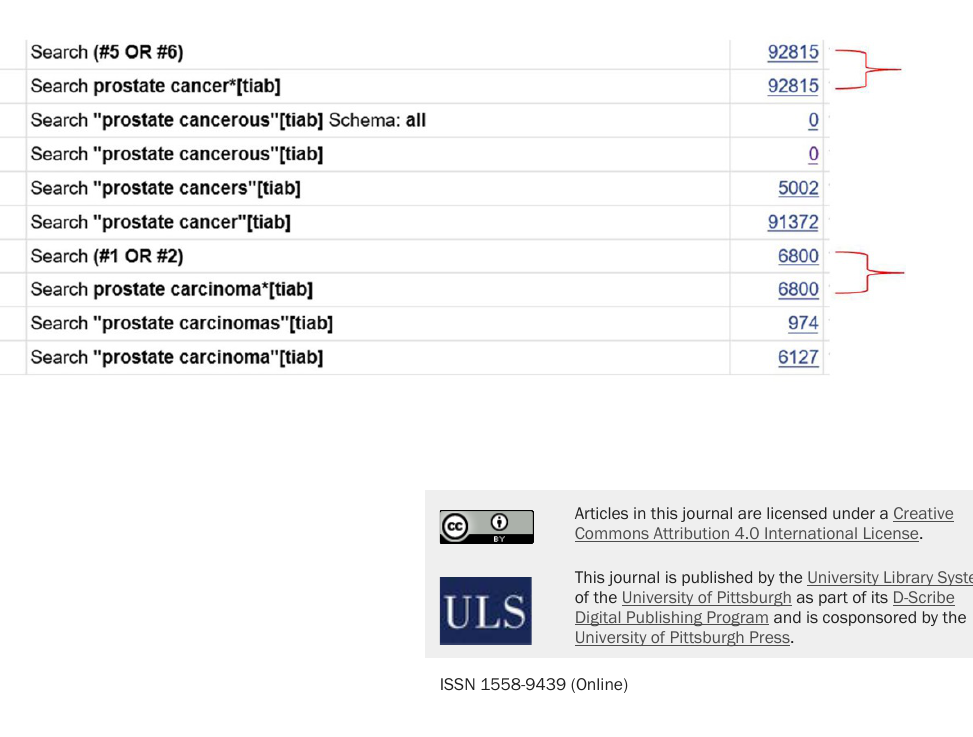
Figure 1 Sample truncation in